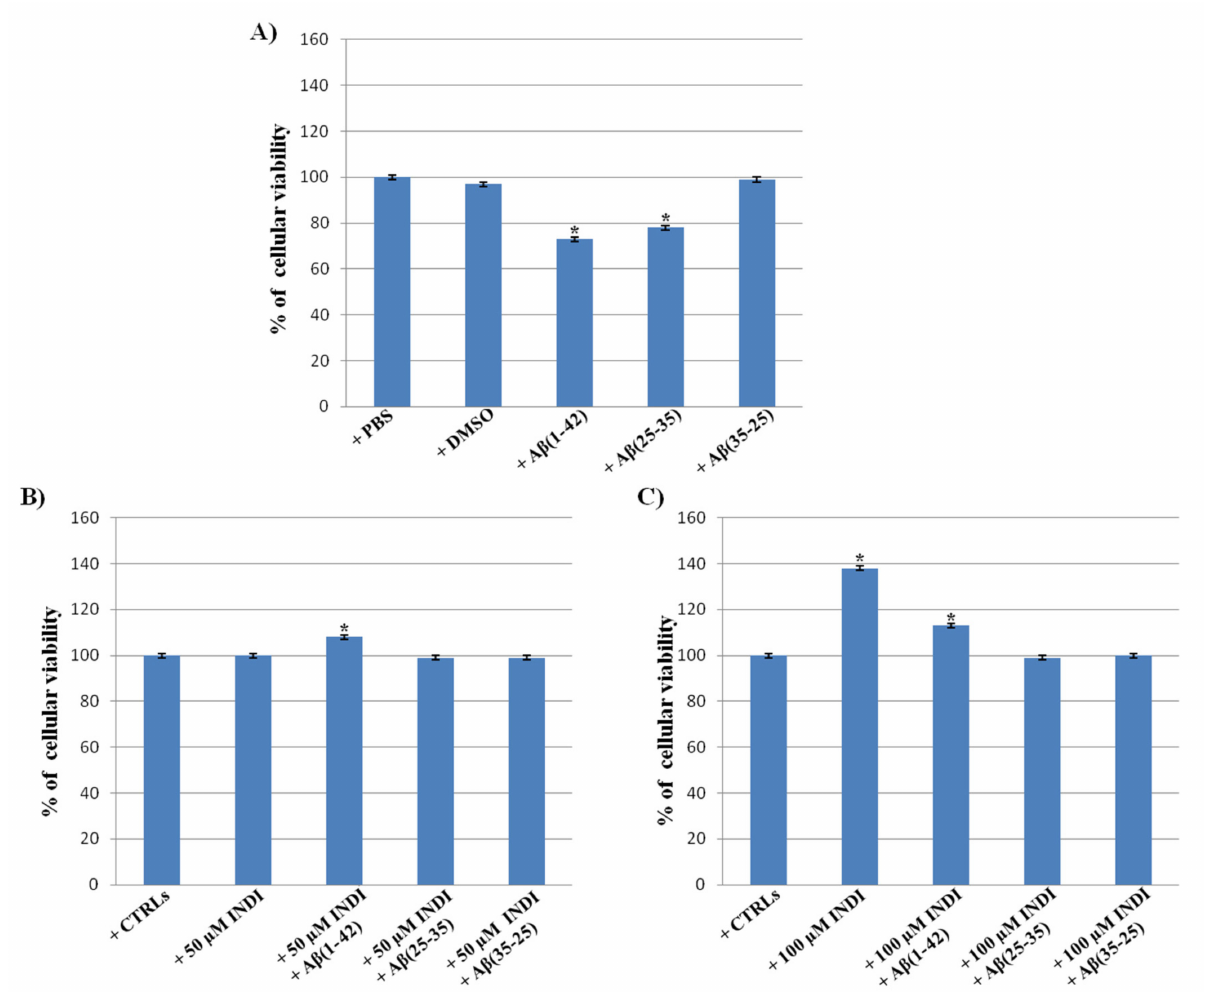
Figure 1. Percentage of cell viability in Olfactory Ensheating Cells (OECs) performed through the 3(4,5-dimethyl-thiazol-2- yl)2,5-diphenyl-tetrazolium bromide (MTT) test. ( A ) Phosfate buffer saline (PBS) and dimethyl sulfoxide (DMSO) treated OECs, exposed to 10 µ M Amyloid Beta (A β ) A β (1-42) or A β (25-35) or A β (35-25) for 24 h; ( B ) OECs pre-treated with 50 µ M indicaxanthin (INDI) and exposed to 10 µ M A β (1-42) or A β (25-35) or A β (35-25) for 24 h; ( C ) OECs pre-treated with 100 µ M INDI and exposed to 10 µ M A β (1-42) or A β (25-35) or A β (35-25) for 24 h. Data were statistically analyzed by using one-way analysis of variance (one-way ANOVA) followed by post-hoc Holm–Sidak test, in order to calculate significant differences among groups. Data reported represent the mean ± S.D. of five separated experiments in triplicate. * p < 0.05 significant differences vs.